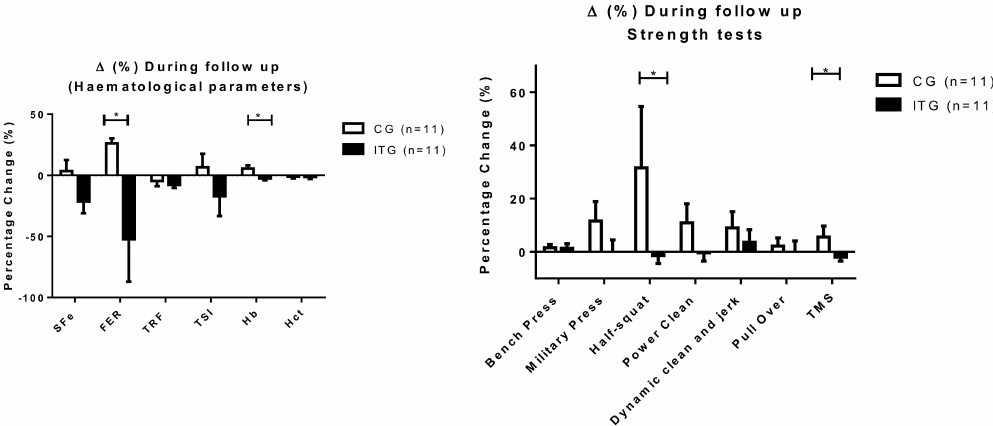
Figure 4. Percentage changes during follow up on hematological parameters and strength performance tests in control group (CG) and iron treatment group (ITG). Data are expressed as means ± standard error. ∆ (%): ((T29 − T11)/T11) × 100; FER= serum ferritin; Hb = hemoglobin; Hct = hematocrit; sFe = serum iron; TSI = transferrin saturation index; TMS = Total Mean Strength: Sum of all strength tests divided by 6. * Significantly different between groups, p < 0.05.